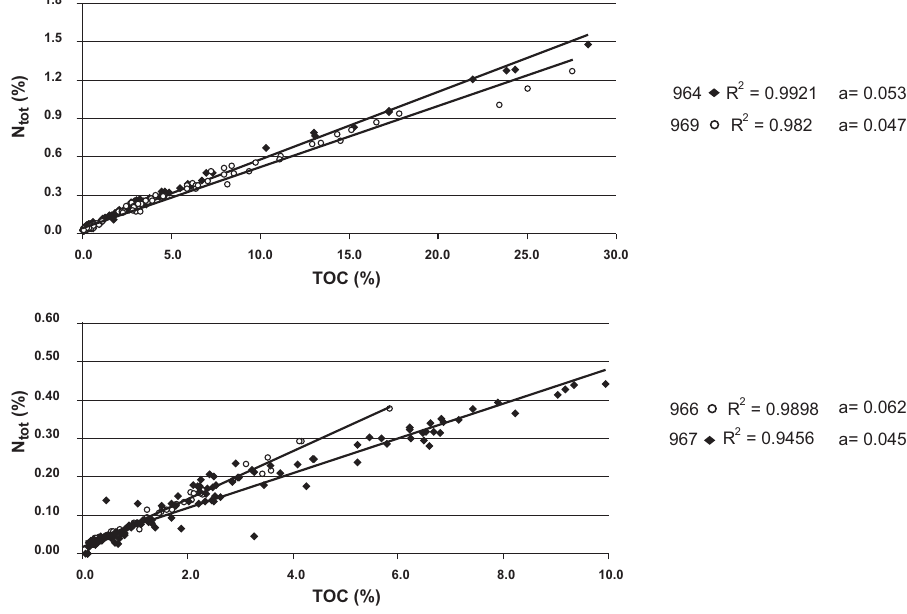
Fig. 12. Total Nitrogen to TOC correlation. Very high correlation indicates that we may consider N tot=N org.